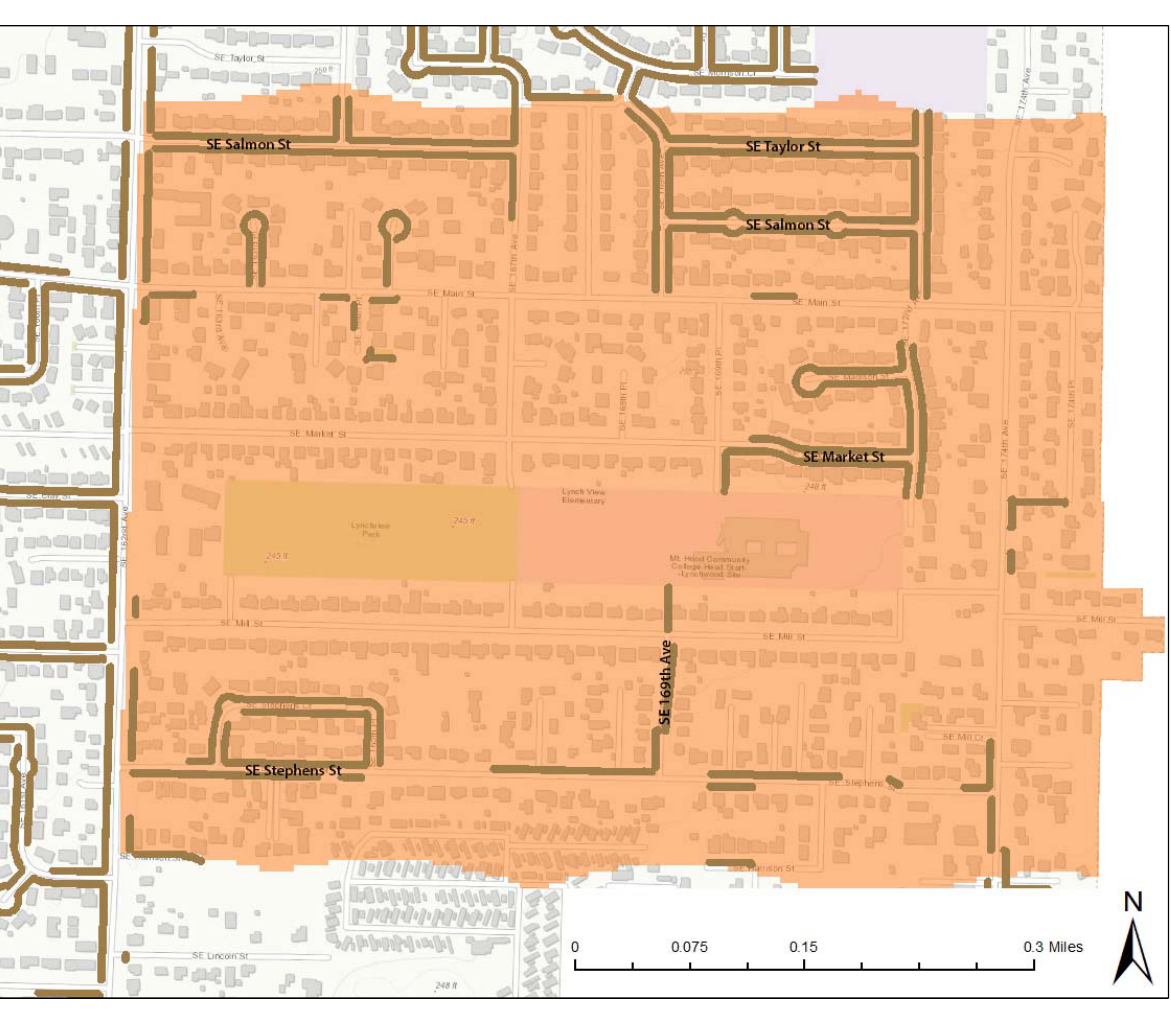
Figure 14. Highlighted Area in Southeast Portland. This area from SE 162nd Avenue to SE 174th Avenue and SE Salmon Street to SE Harrison Street contains Lynch View Elementary, a Head Start site, and Lynchview